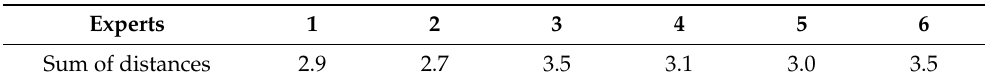
Table 3. Kemeny median between the opinion of one expert in relation to the others for the second parameter for 6 experts.